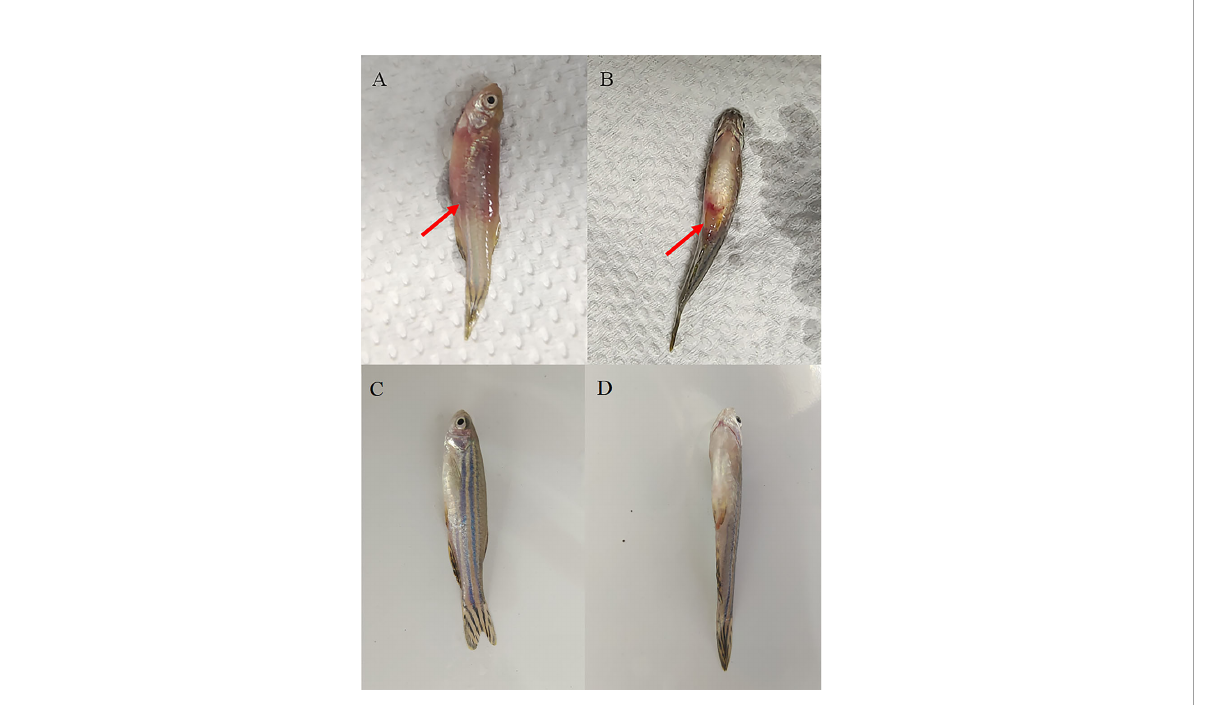
FIGURE 6 Clinical signs of Vibrio infection. Symptoms of Danio rerio fi ngerlings experimentally infected with MEDF7 (red arrow). (A, B) : Diseased fi sh group; (C, D) : Healthy fi sh